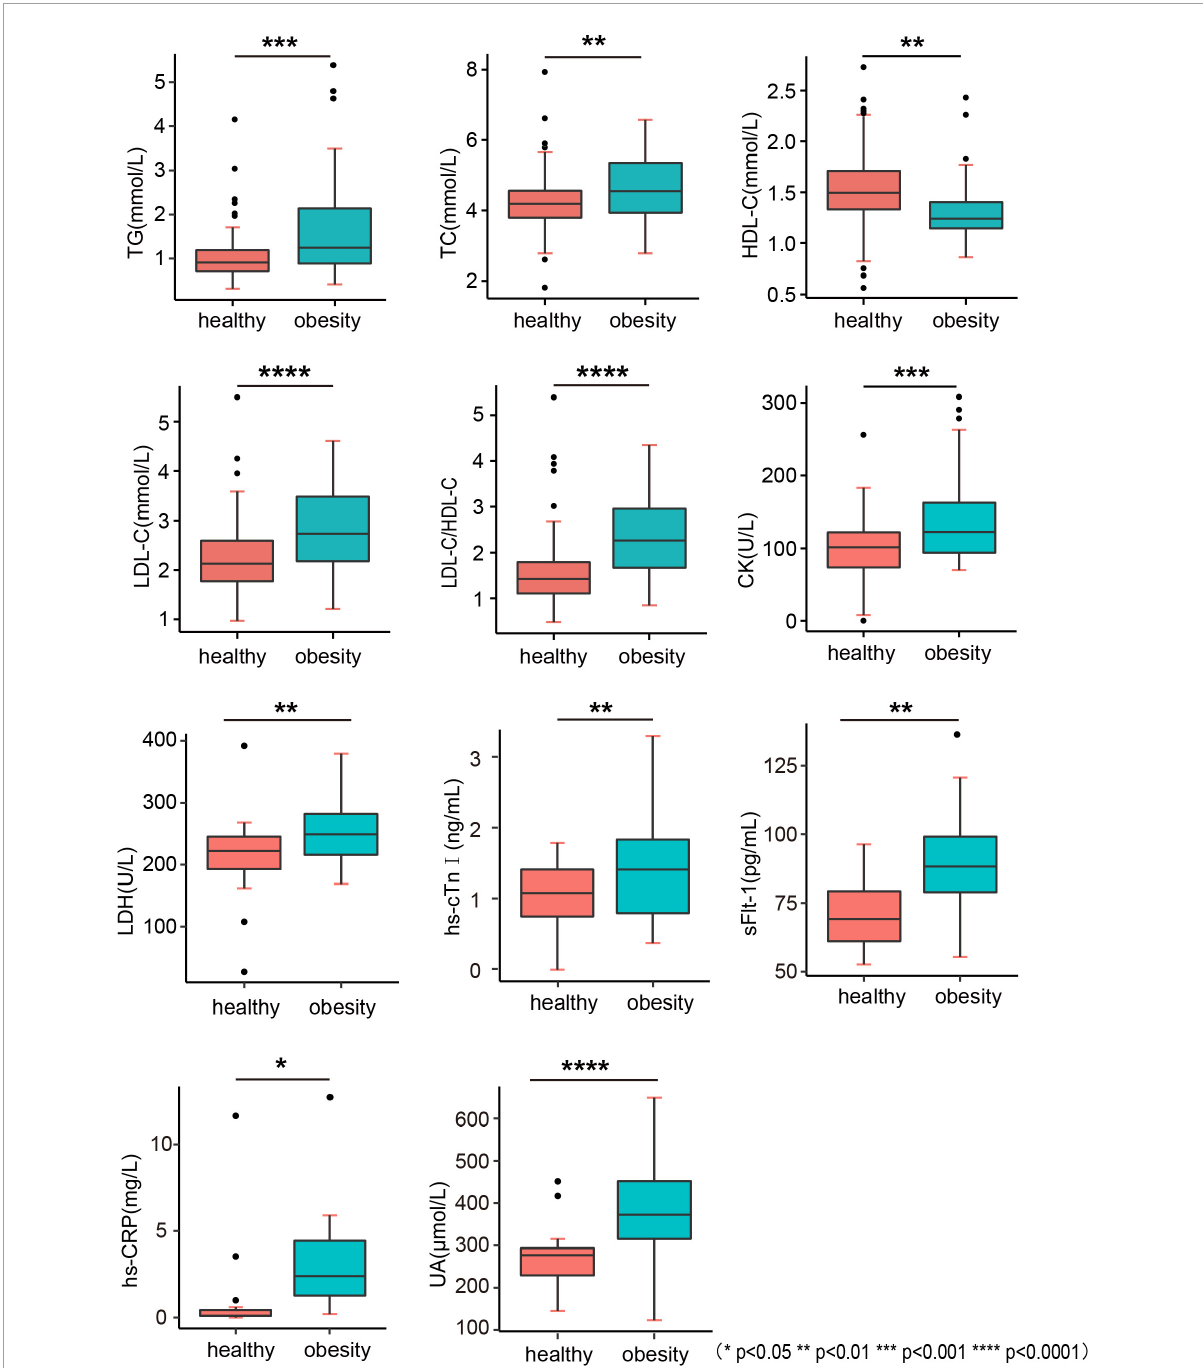
FIGURE3 Biochemistry indicators. TG, triglyceride; TC, total cholesterol; HDL-C, high-density cholesterol; LDL-C, low-density lipoprotein cholesterol; LDL-C/HDL-C, LDL-C to HDL-C ratio; CK, creatine kinase; LHD, lactate dehydrogenase; hs-cTnI, high-sensitivity cardiac troponin I; sFlt-1, fms-like tyrosine kinase-1; hs-CRP, high-sensitivity C-reactive protein; UA, uric